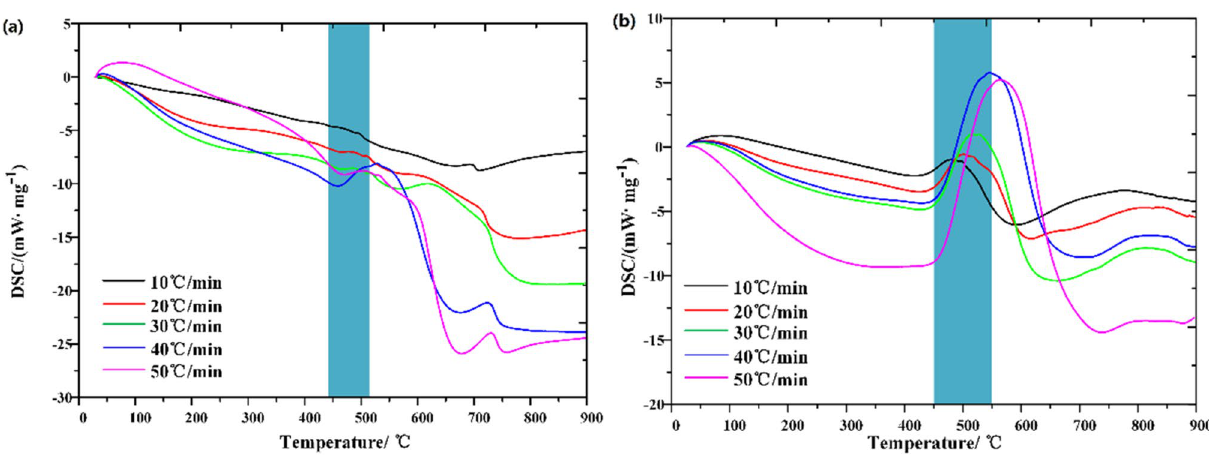
Figure 12. DSC curve of Huadian oil shale ( a ) N 2 ( b ) CO 2